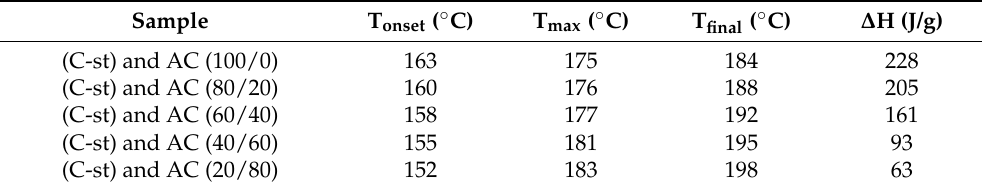
Figure 3. DSC thermograms of C ‐ st/AC blends. Table 2. DSC data of C ‐ st/AC blends.